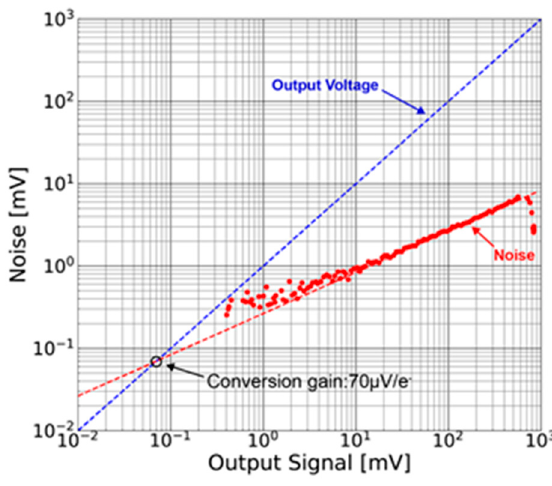
Figure 14. Noise versus signal for conversion gain measurement.